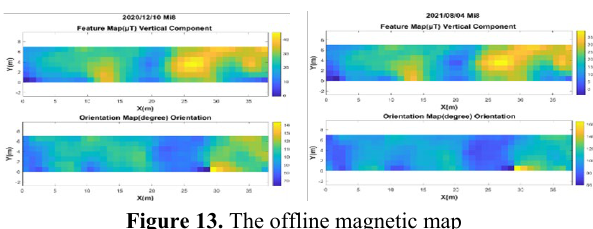
Figure 13. The offline magnetic